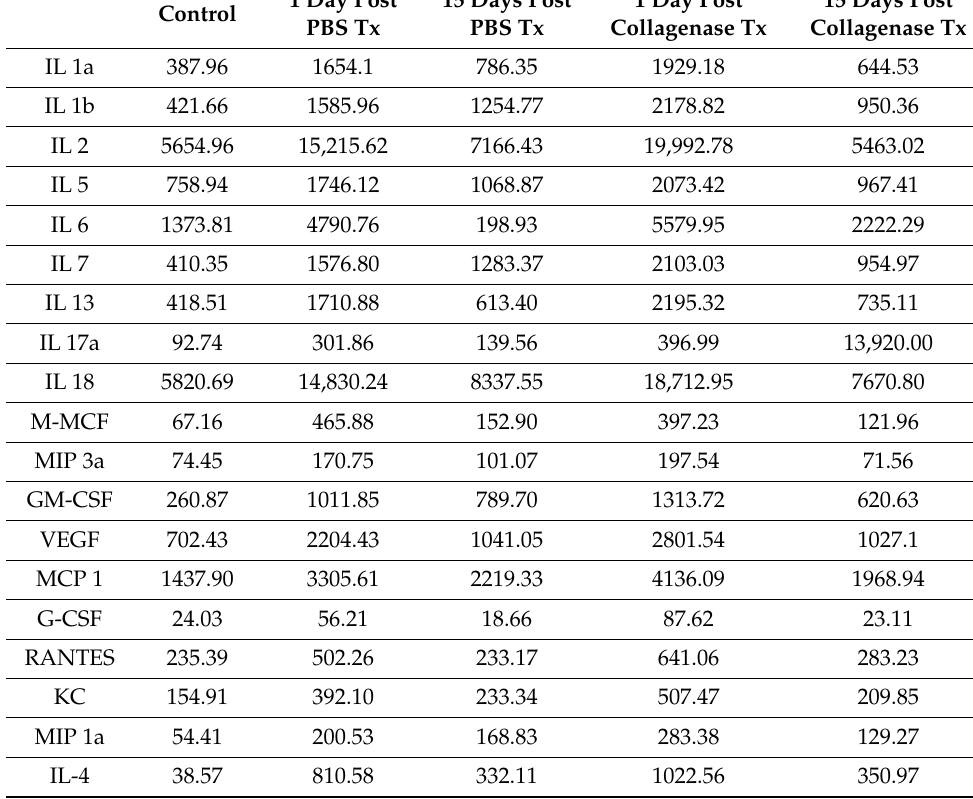
Table 1. Results of circulating cytokine